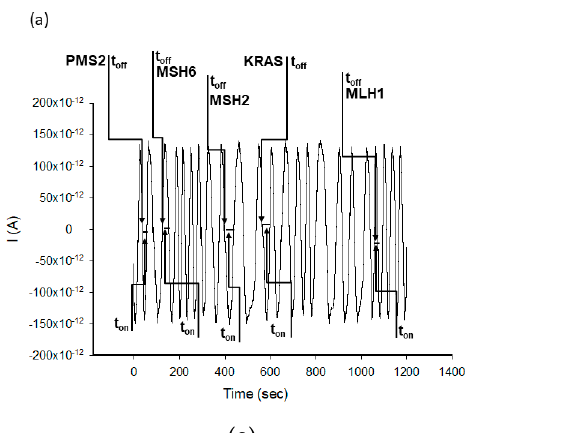
Figure 3. Examples of diagrams obtained for the screening tests of saliva using the stochastic sensors based on: ( a ) MD/EGR-1 and ( b ) MD/EGR-2.